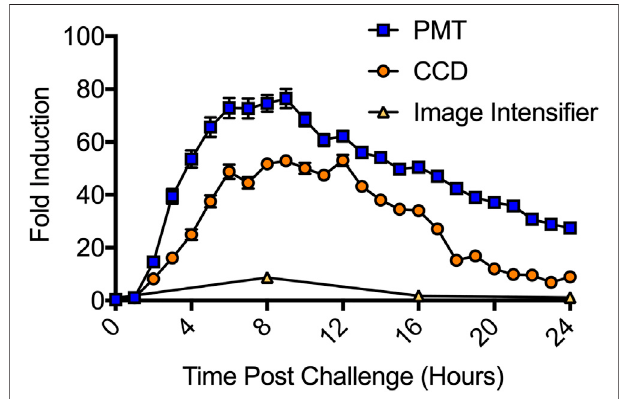
FIGURE 6 | Detection of CRE induction following forskolin treatment. The PMT system was the most sensitive system tested. It detected signi fi cant inductionat2 hposttreatmentandrecordedamaximuminductionof76-fold. The CCD system was the second most sensitive. It also detected signi fi cant induction at 2 h post treatment, but only recorded a 53-fold maximum induction. The image intensi fi er system required 8 h to report a signi fi cant induction and only observed a 9-fold maximum induction. The CMOSsystem(notshown)didnotdetectsigni fi cantinductionatanysurveyed time point. n (cid:2) 3; error (cid:2)